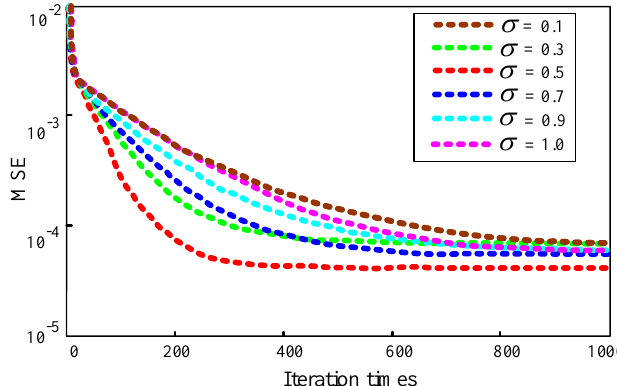
Figure 7. SOC estimation results under different kernel widths.